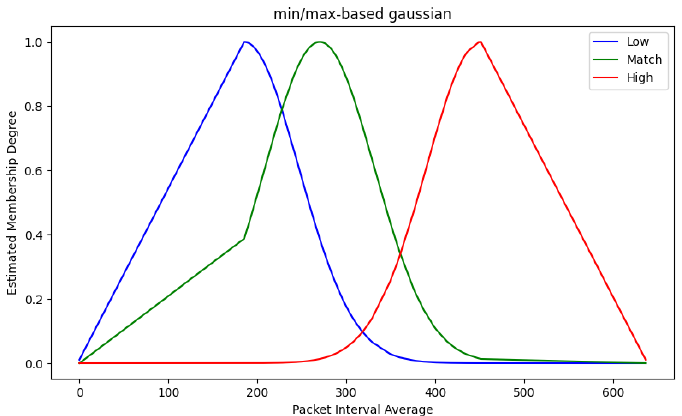
Figure 10. Membership function with the padding method applied. This membership function is calculated for all input features. Through this, the membership degree for the input of the target traffic is then